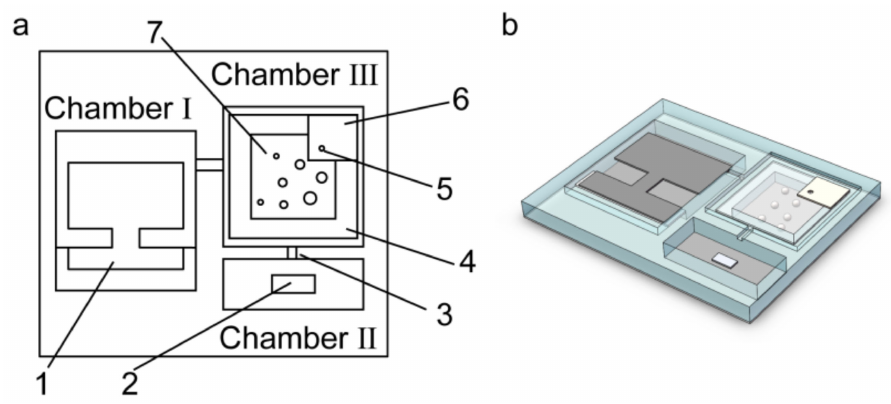
Figure 1. Structure diagram of the MEMS particle chamber. ( a ) Top view of the MEMS particle chamber (1: Resonator, 2: Getter, 3: Micro-channels, 4: Small glass sheet with one hole, 5: Micropore, 6: Tinfoil; 7: Vaterite particles); ( b ) Three-dimensional stereogram of the MEMS particle chamber.